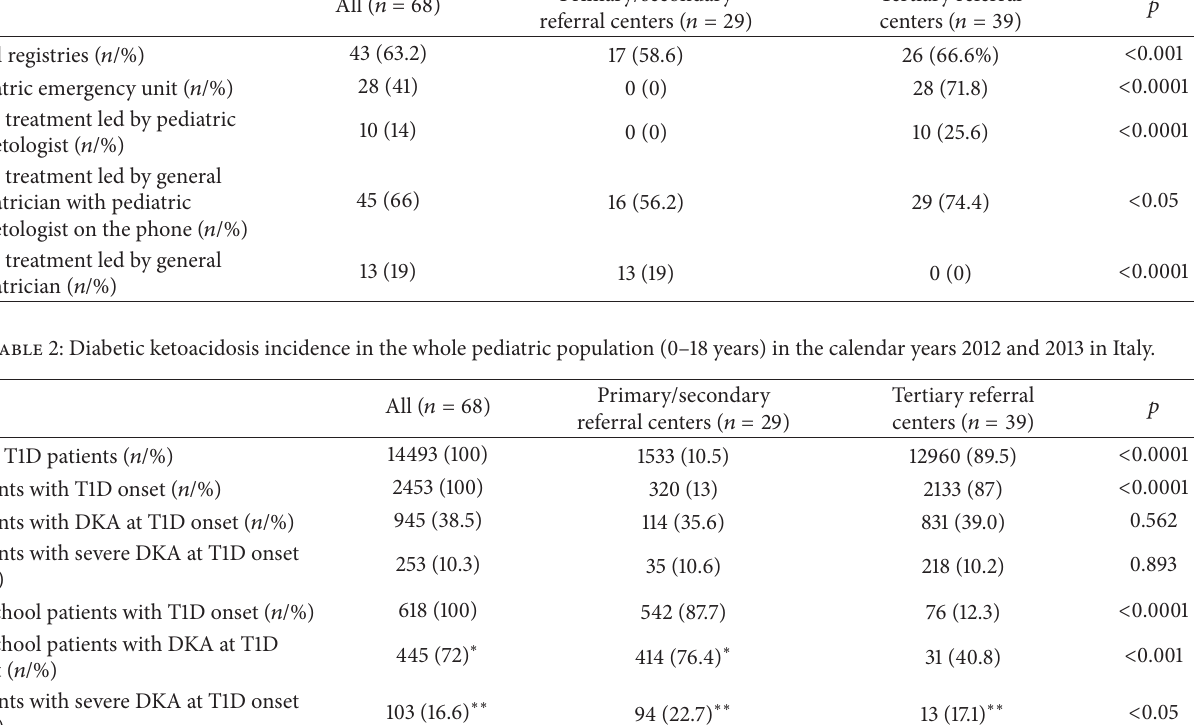
Table 1: Demographic characteristic of the 68 participating centers, according to being primary/secondary or tertiary referral centers. All ( 𝑛 = 68 )